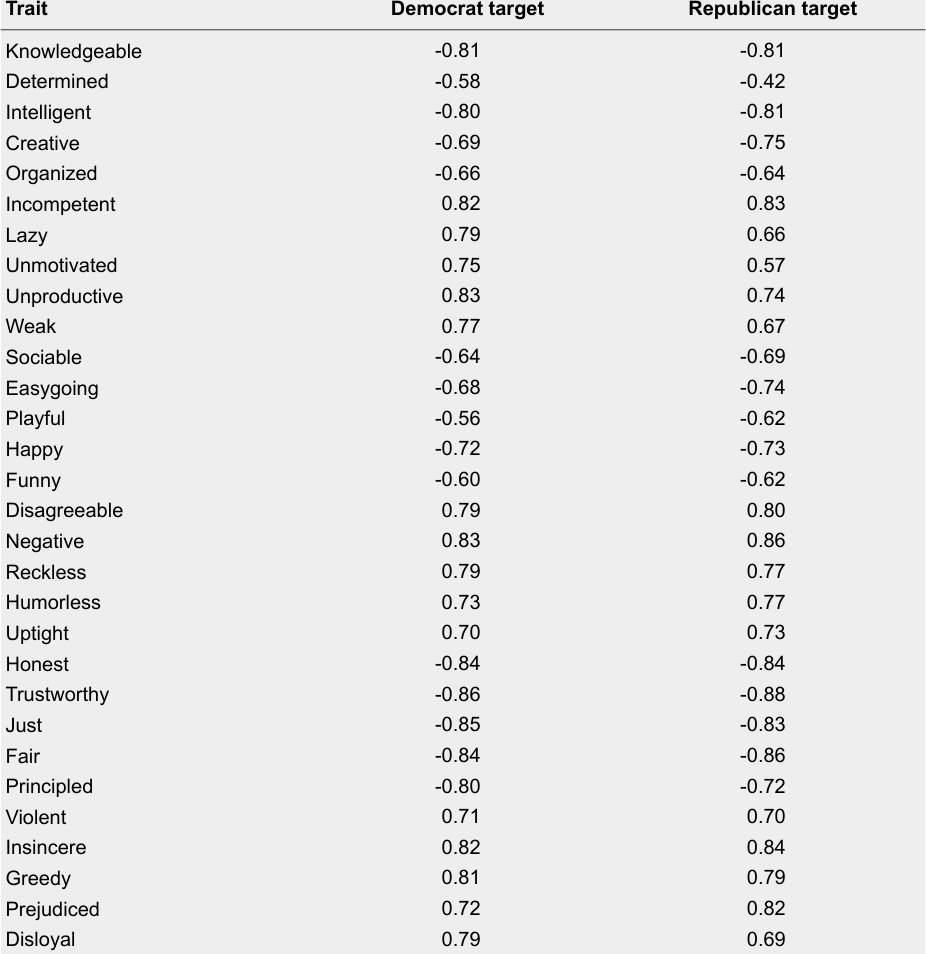
Factor Loadings From Exploratory Factor Analysis (Study